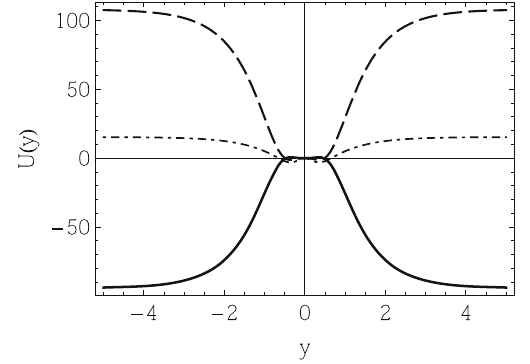
= 1 . 6 (dotdashed 0